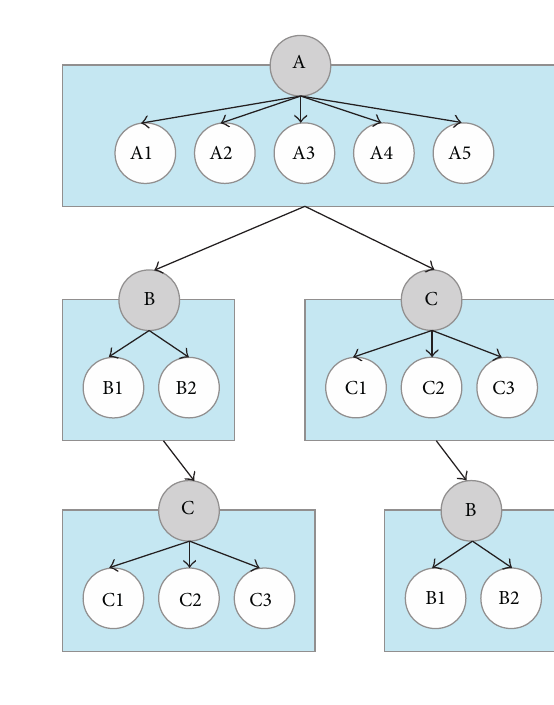
Figure 4: Double P.P.M. scheme.